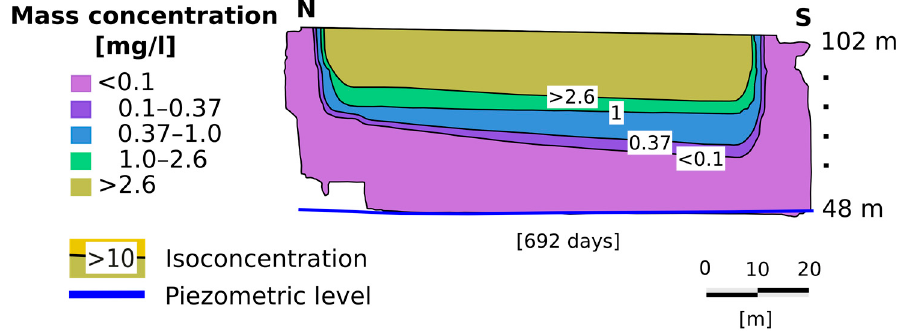
Figure 12. Concentration of 8 × 10 − 5 mg/l of dissolved benzene detected on the water table at 692 days.